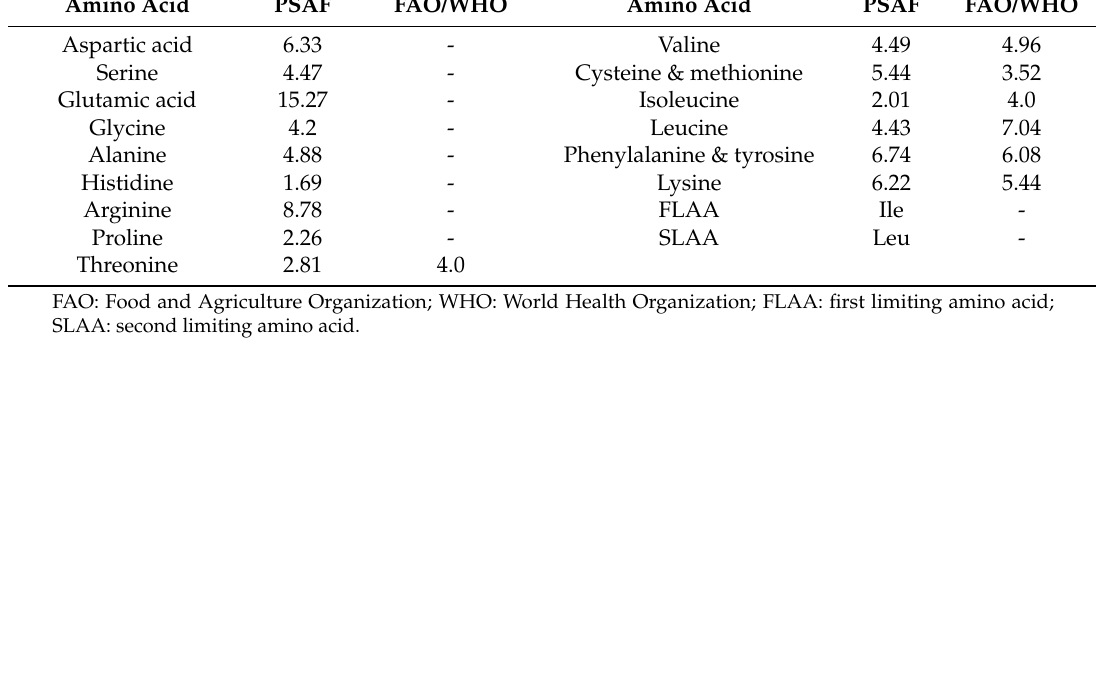
Table 2. Analysis of amino acids composition (mg/100 mg) of PSAF.